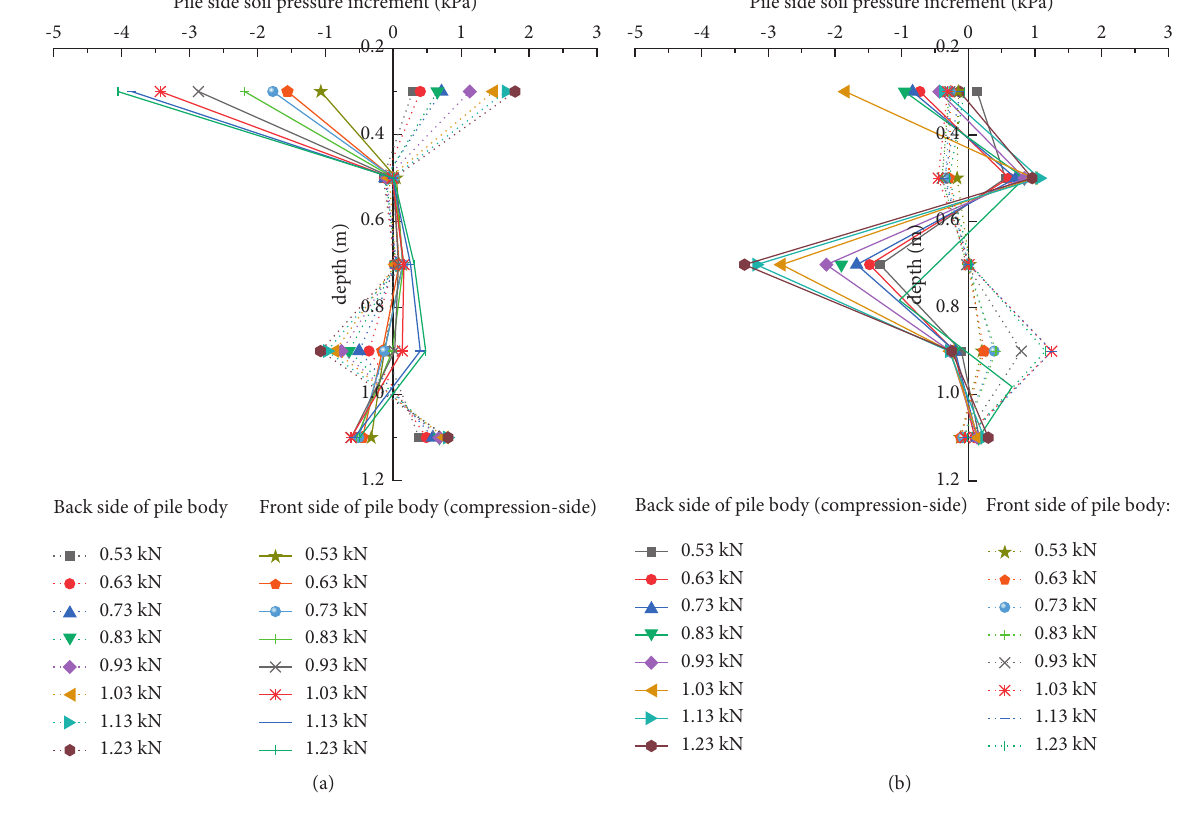
Figure 9: Soil pressure distribution on the front and back sides of the pile during cyclic reciprocating loading. (a) In forward loading process. (b) In reverse loading process.